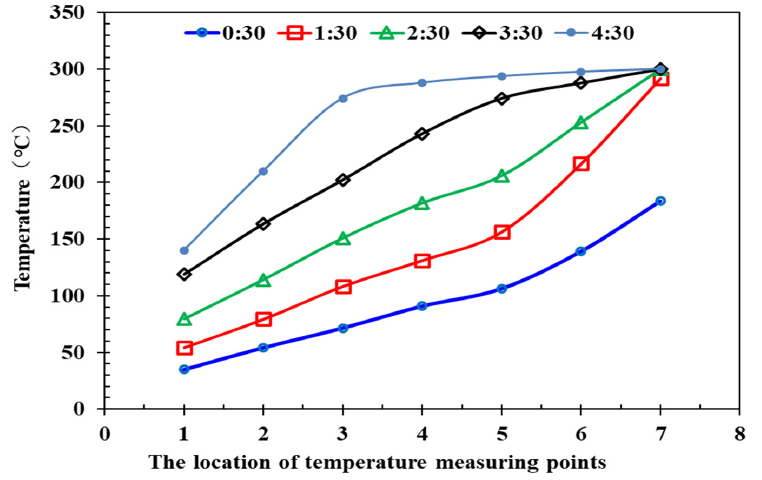
Figure 4. The heat transfer characteristics of model while injecting heat-conduction oil.